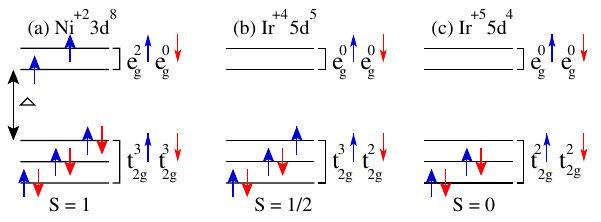
2 3 d 8 4 5 d 5 5 5 d 4 , ( b ) Ir + , and ( c ) Ir + orbital